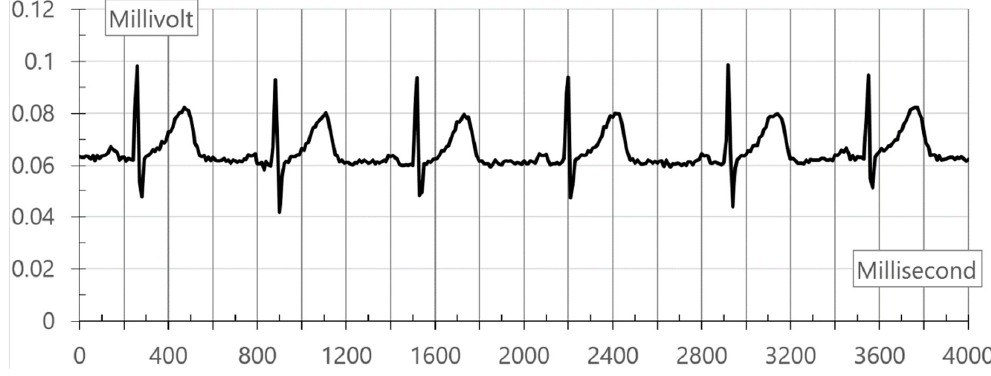
Figure 2. Collected ECG packets graphs.